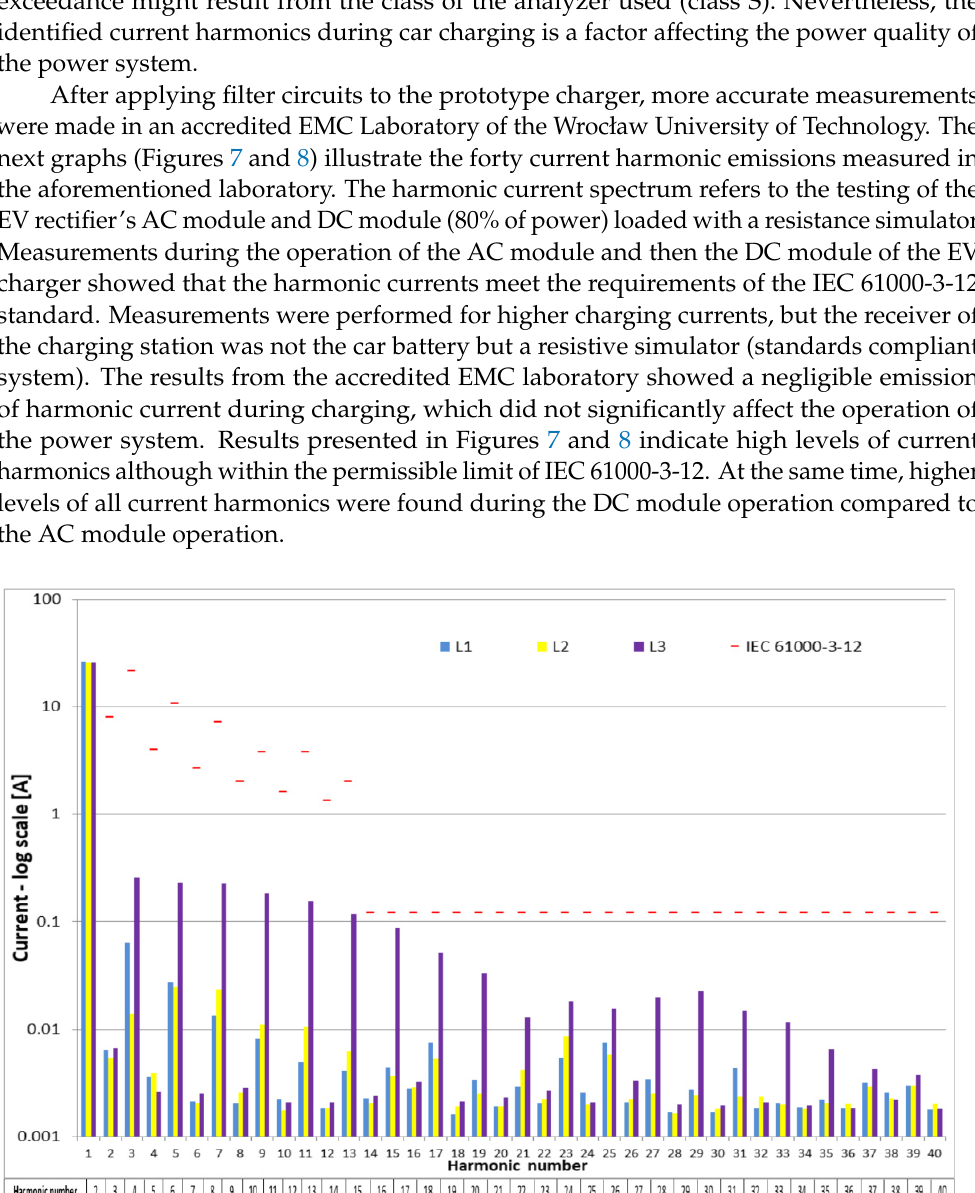
Figure 8. The harmonic current spectrum of a DC module (80% of power). The calculated values of current total harmonic distortion (THD I ) are presented in Table 1. All values of THD I were within the permissible range of the IEC 61000 ‐ 3 ‐ 12 stand ‐ ard. The highest values were observed during AC module operation. This might be a re ‐ sult of the operation of the bidirectional isolated DC/DC converter with dual active bridge topology implemented in the charger.